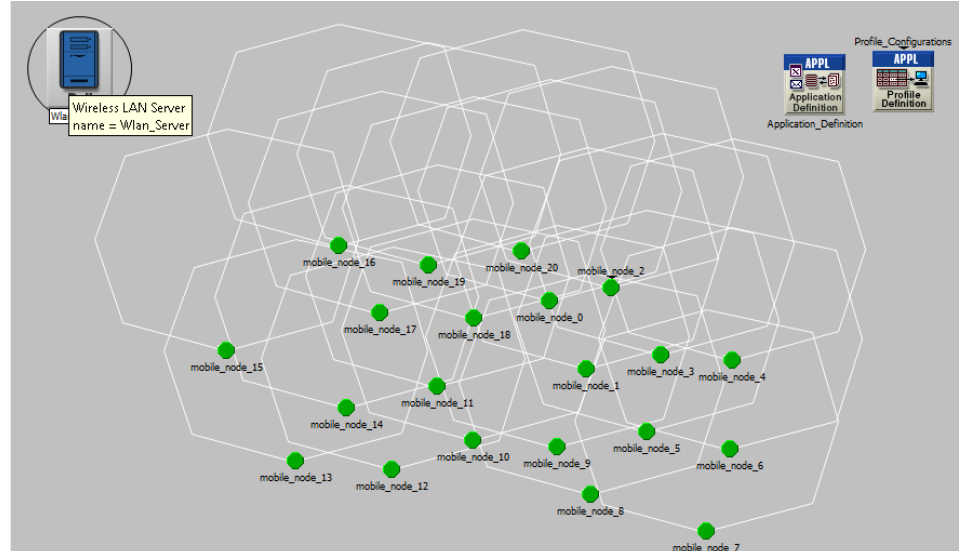
Fig. 1. Simulation